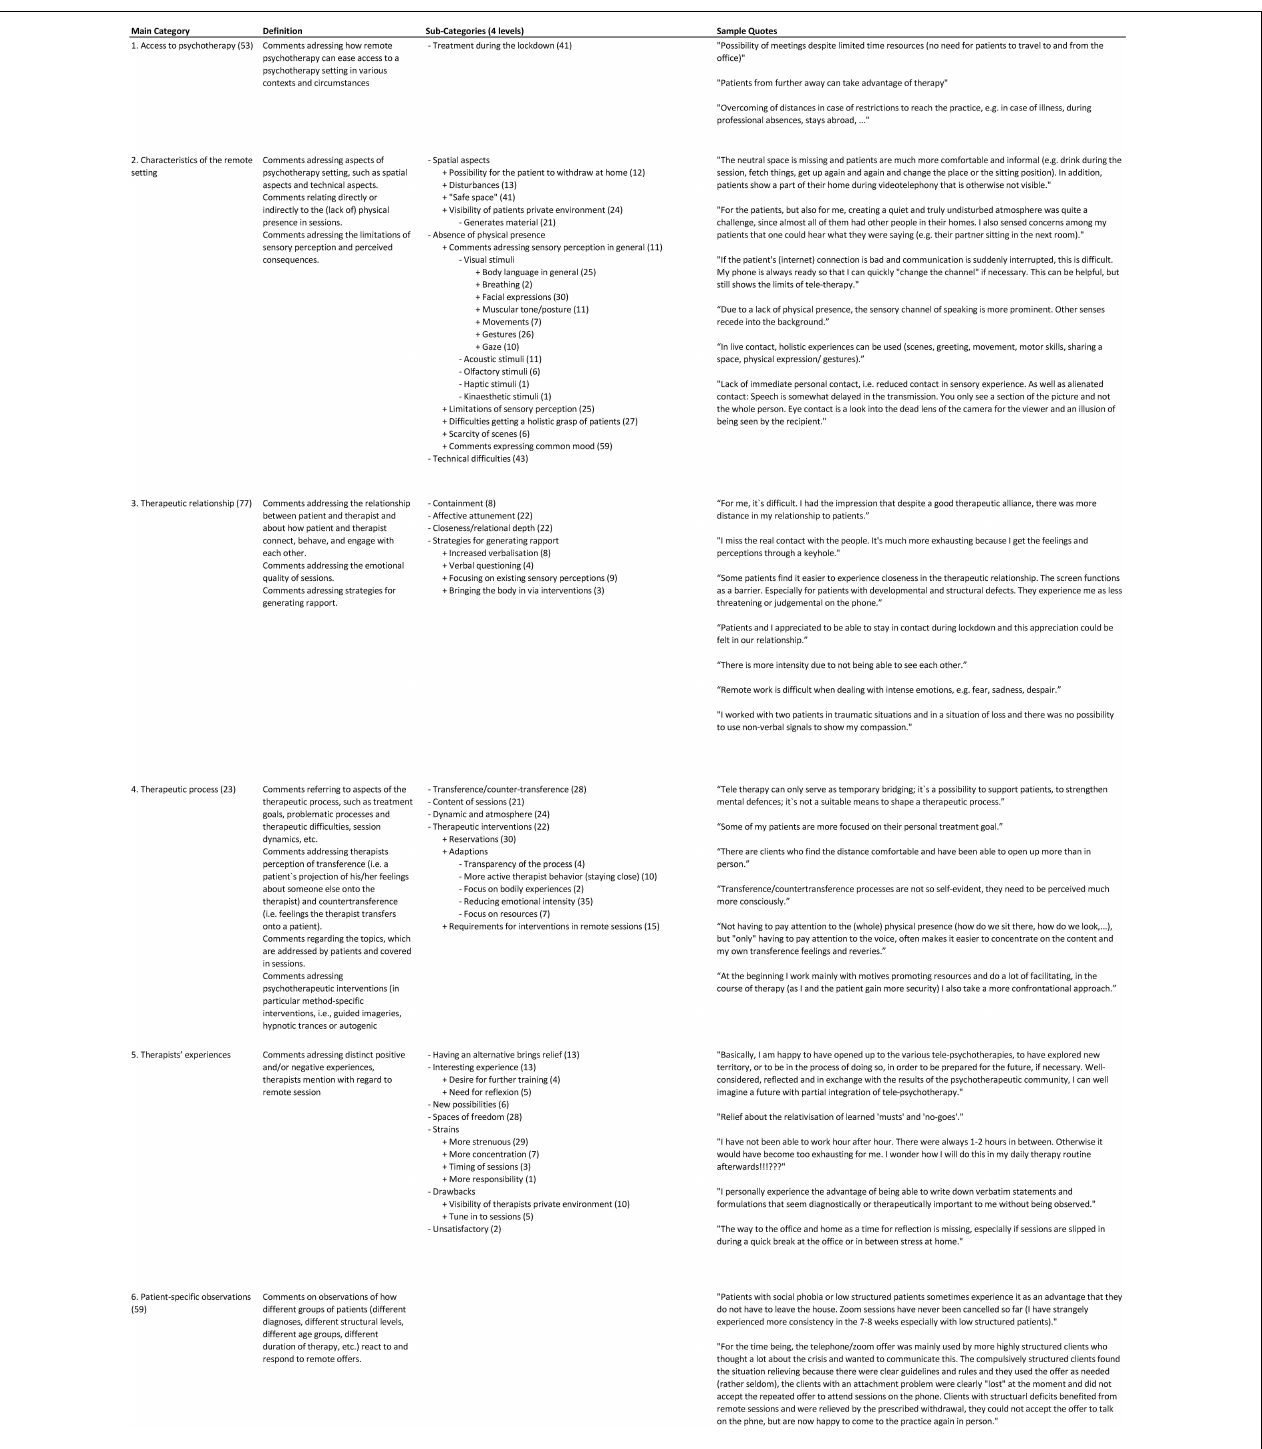
FIGURE 1 | Provides an overview of the structure of categories. Column 1 captures the main categories by which the chapters of the paper are organized. Column 2 provides a category definition. For larger categories, definitions of sub-categories at level 2 are included as well. Column 3 lists the associated sub-categories. The indentation indicates the level of the sub-category. Sub-sub-categories are indented accordingly. Column 4 contains a selection of quotations for the respective main category. Attention has been paid to illustrate different aspects of the main category in the quotations. The numbers in brackets indicate the number of allocated text passages. In some cases, the main categories function as an umbrella for sub-categories and do not themselves contain quotations. In other cases, more general comments have been subsumed under the main category and more detailed comments addressing specific aspects of the main category have been subsumed in different